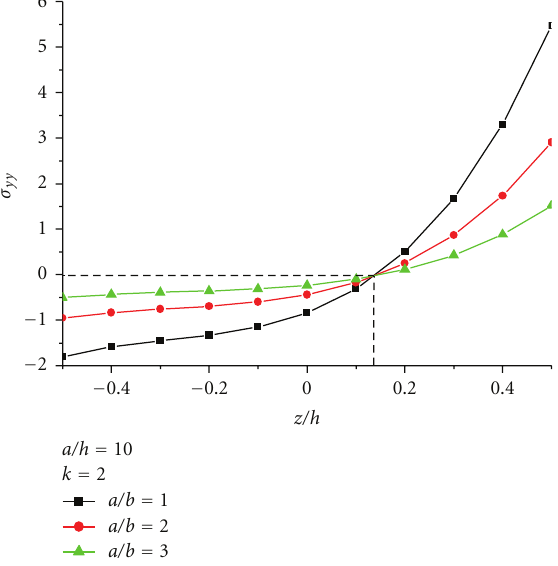
Figure 6: Variation of in-plane normal stress ( σ yy ) through-the thickness of an FGM plate for di ff erent values of the aspect